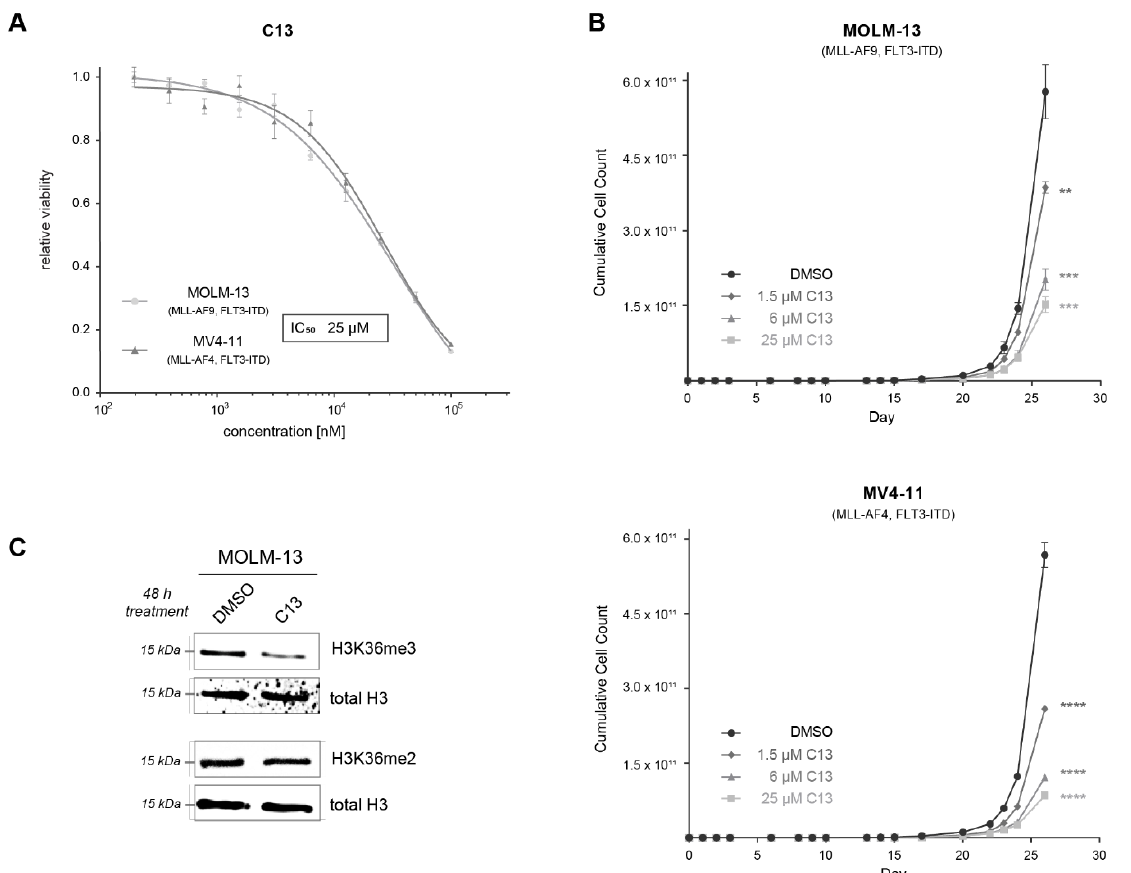
Figure 5. The confirmed hit compound C13 inhibits the proliferation of leukemia cell lines and inhibits the enzymatic activity of SETD2 in cells. ( A ) Dose–response curves of MOLM-13 and MV4-11 cells treated for 5 days with different concentrations of C13, resulting in an IC 50 value of 25 µM. ( B ) Proliferation assay of AML cell lines treated with three different concentrations of C13 and DMSO as control. Cells were treated every 48 or 72 h, and cell counts were determined in regular intervals; IC 10 = 1.5 µM, IC 20 = 6 µM, IC 50 = 25 µM. ( C ) Western blot analysis of MOLM-13 cells treated for 48 h with 100 µM C13 or DMSO. Membranes were incubated with antibodies against H3K36me3 and H3K36me2. Total H3 was used as a loading control. ** p < 0.01, *** p < 0.001, **** p < 0.0001.